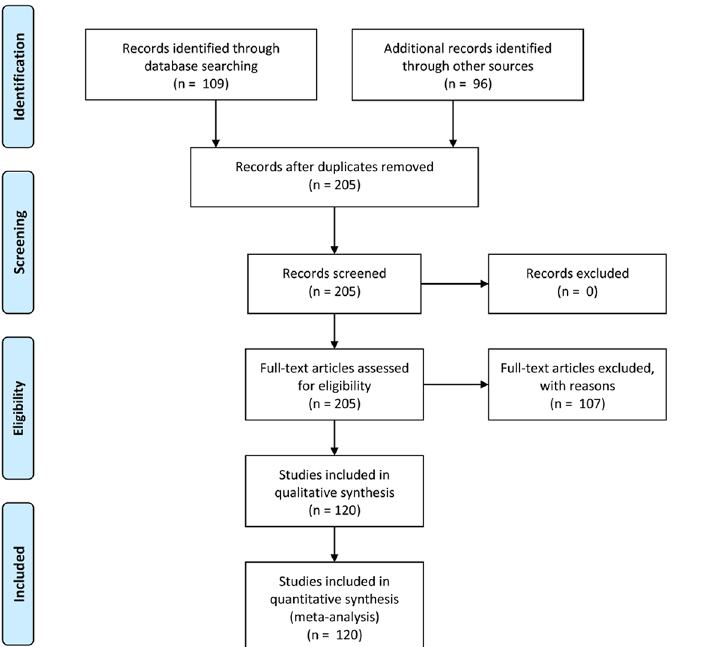
Fig 2. PRISMA flowchart of the current